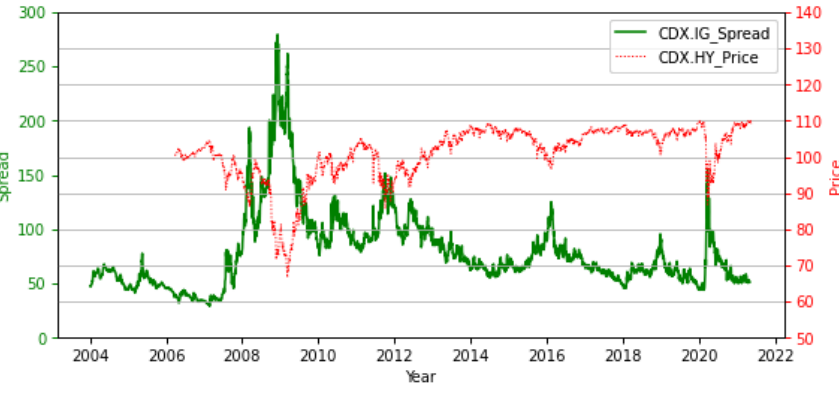
Figure 2. CDX.IG (spread) and CDX.HY (price).